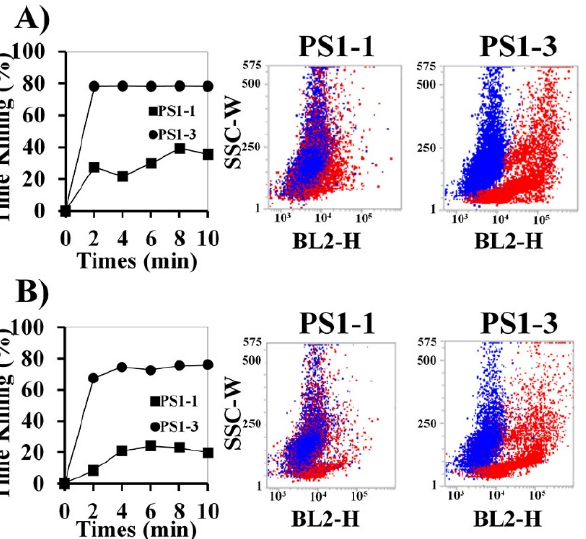
Figure 2. Inhibitory effects of PS1-1 and PS1-3 peptides against C. albicans cells. Time-kill kinetics of PS1-1 and PS1-3 peptides with C. albicans (5 × 10 5 cells/mL) within SP ( A ) and PBS buffer ( B ). The cells were stained with propidium iodide (PI) and recorded per each 2 min interval by FACS. Blue and red dots present non-treated and treated cells, respectively. All values represent three individual experiments.